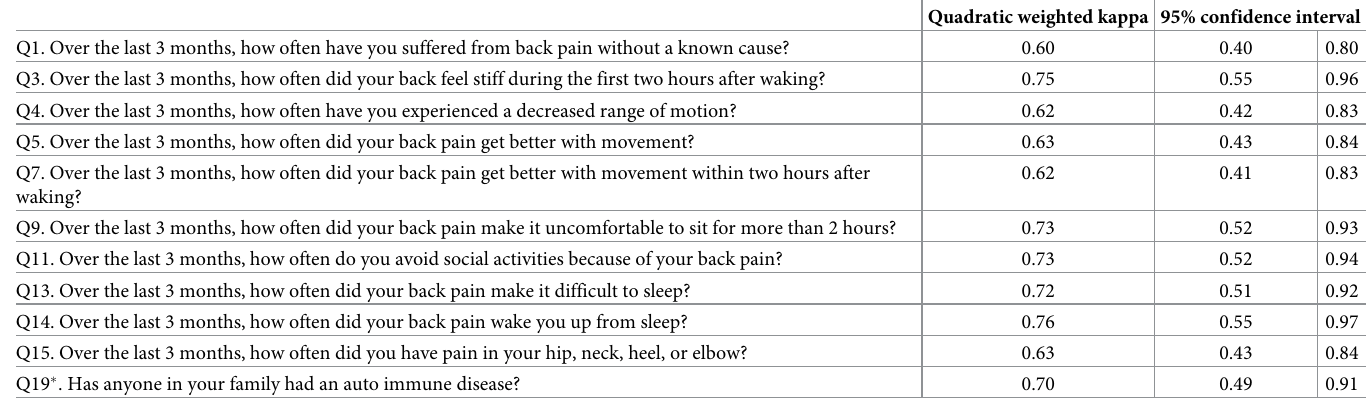
Table 3. List of questions with moderate correlations (kappa � 0.6).